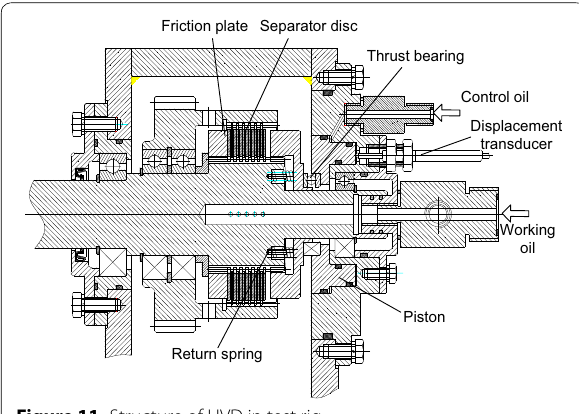
Figure 11 Structure of HVD in test rig